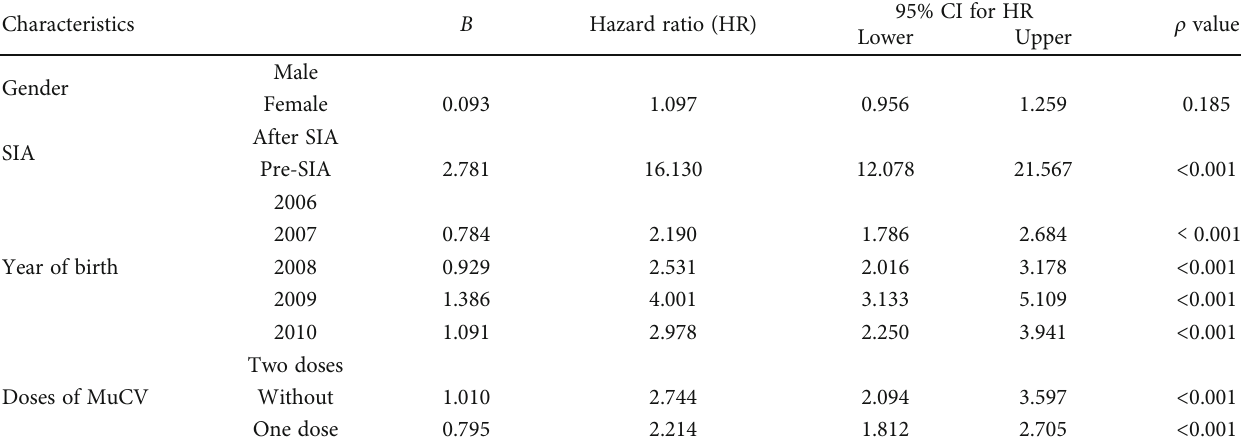
Figure 1: The Kaplan-Meier curves showing the cumulative hazard of mumps. Table 3: Results from Cox-proportional hazard regression model depicting the risk of